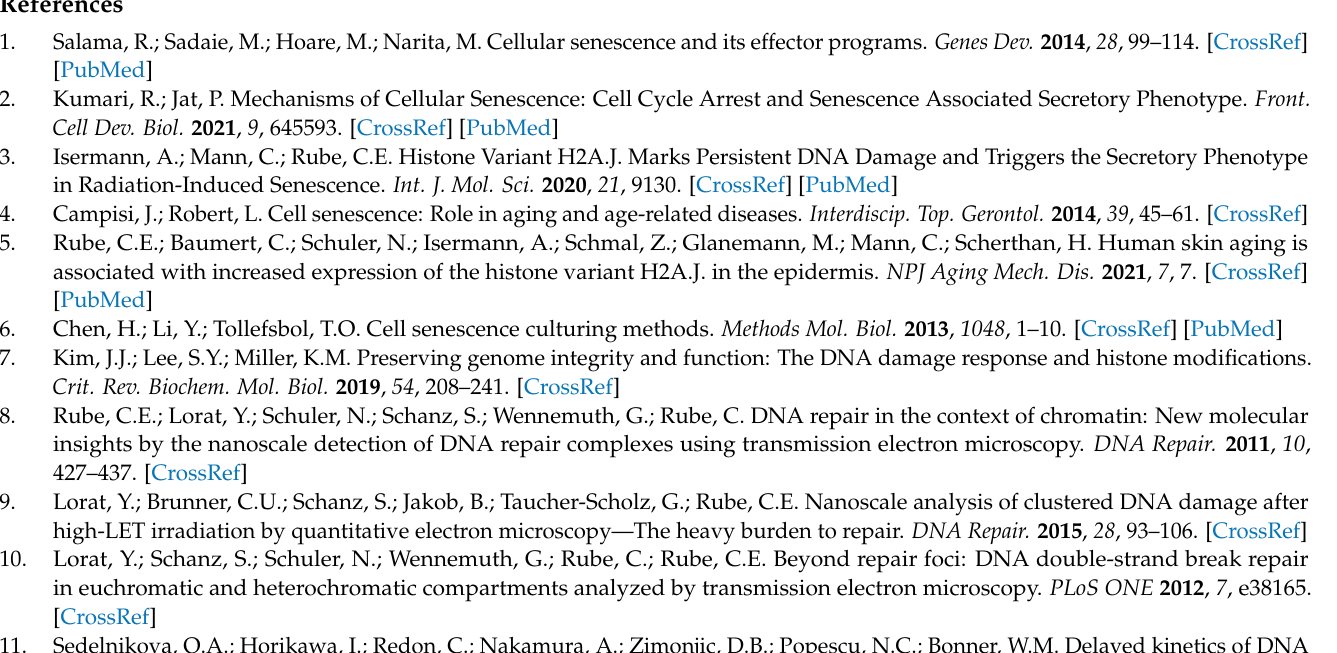
fibroblasts. Figure S2: CCF formation and cGAMP concentration: Quantification of CCF-positive cells by IFM for non-irradiated (non-IR) and irradiated (20 Gy, 2 weeks post-IR) fibroblasts (right panel). Quantification of cGAMP concentration: Quantification of cGAMP protein relative to total protein (g = gram) in non-irradiated (non-IR) and irradiated (20 Gy, 2 weeks post-IR) fibroblasts (left panel). Figure S3: SBF-SEM: fusion of CCF with lysosomes: High-resolution display of the fusion of CCF with lysosomes to become autolysosomes, in which the sequestered cargos are degraded and recycled for the maintenance of cellular